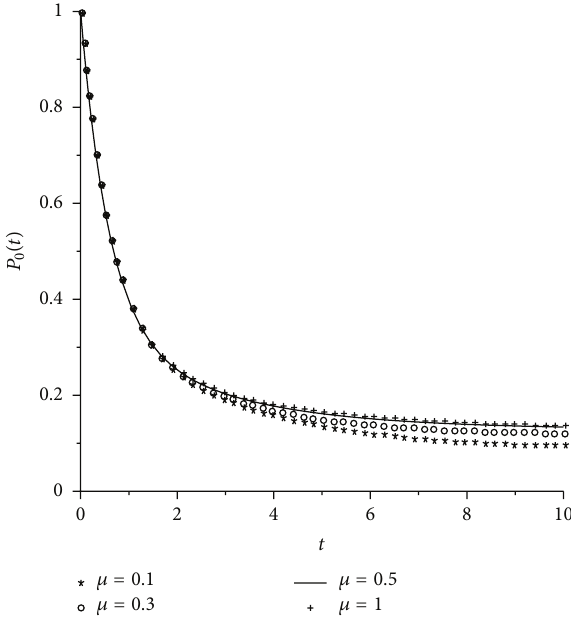
Figure 3: Instantaneous probabilities of the system without warning device in good state with different 𝜇 .